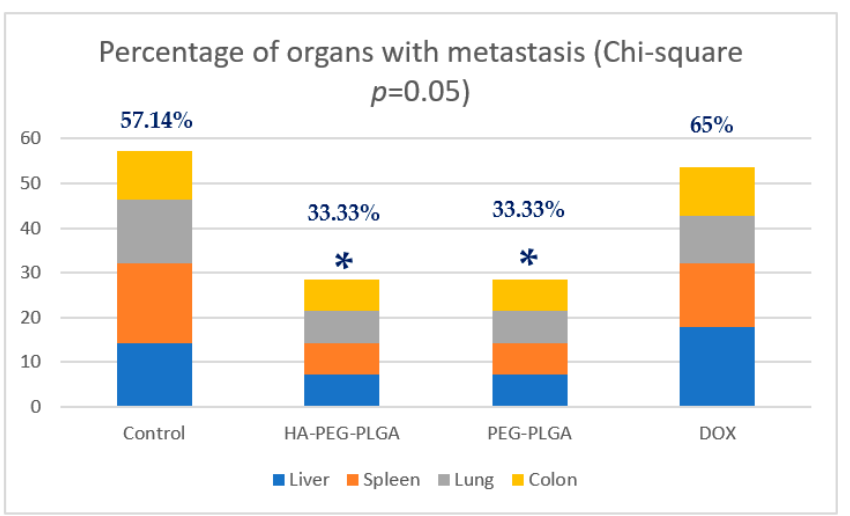
Figure 5. Percentage of organs collected from each group with metastasis detected under fluorescent microscope (* p ≤ 0.05 compared to control group) (DOX: free doxorubicin, PEG-PLGA: Doxorubicin loaded PEG-PLGA nanoparticles, HA-PEG-PLGA: Hyaluronic acid coated Doxorubicin loaded PEG-PLGA nanoparticles).